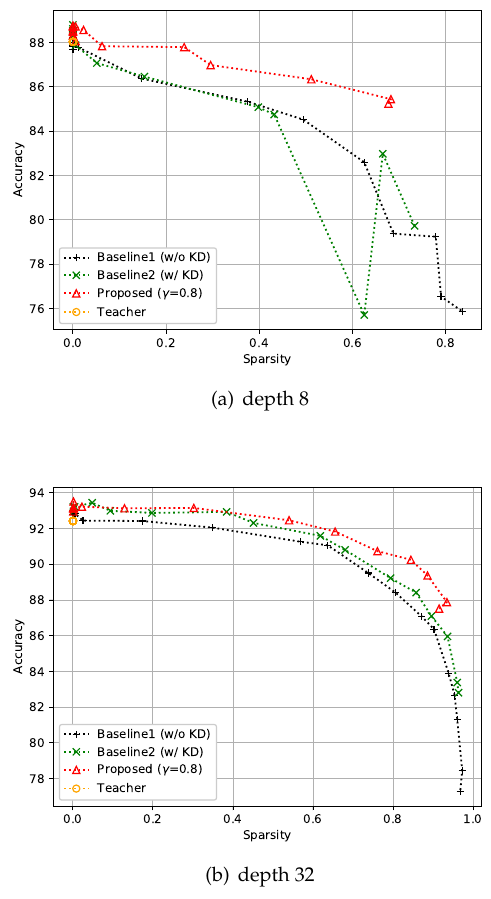
Figure 5. Effect of the proposed strategies on CIFAR-10. Here, the hyper-parameter γ is the relaxation variable shown in Equation